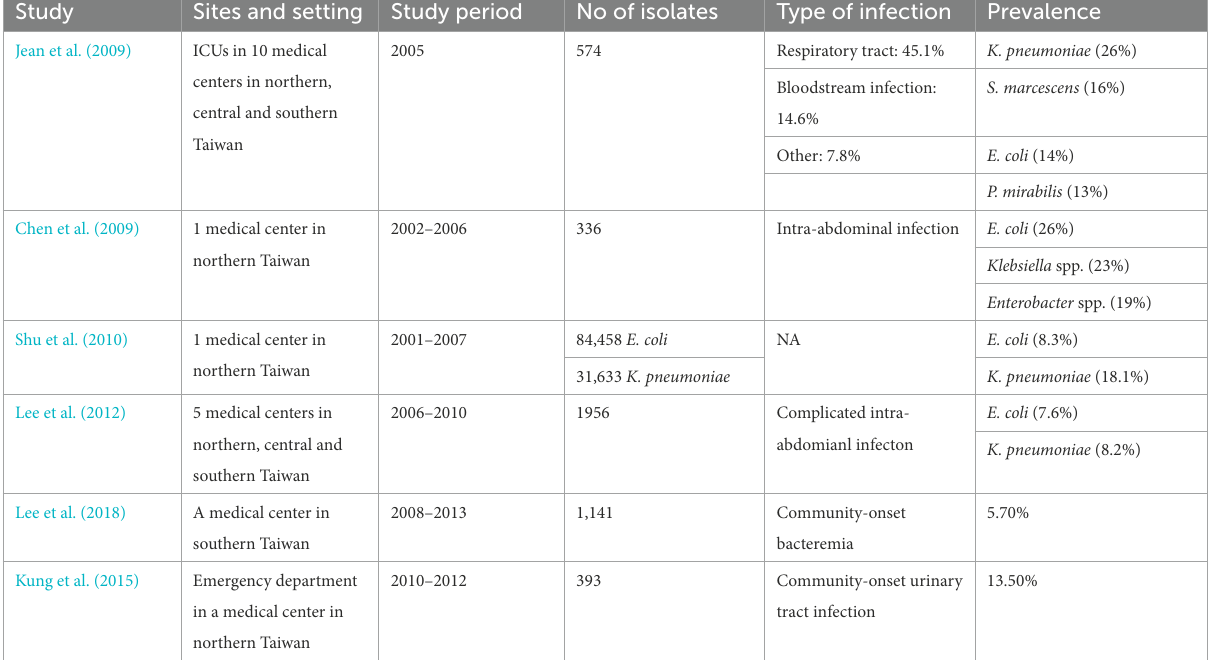
TABLE 1 Prevalence of extended-spectrum β -lactamases (ESBLs) among Enterobacterales in